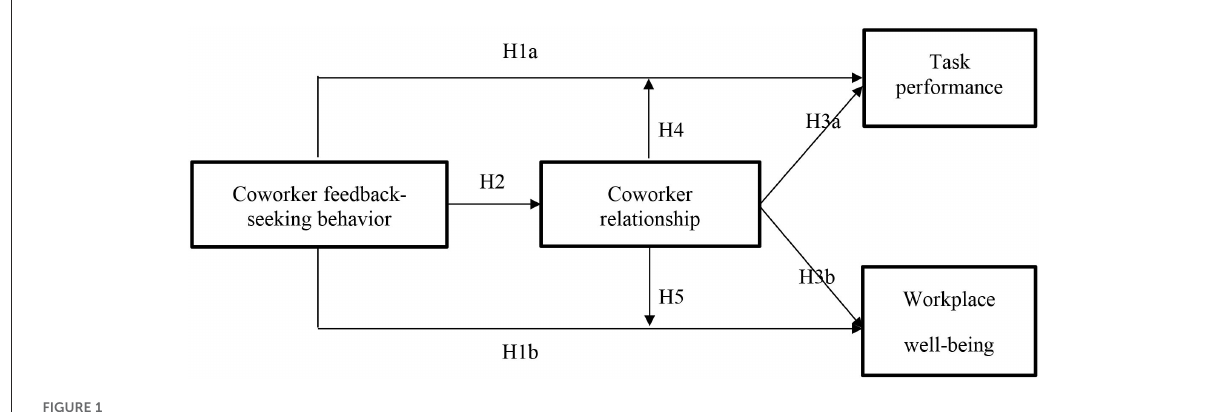
FIGURE1 The theoretical